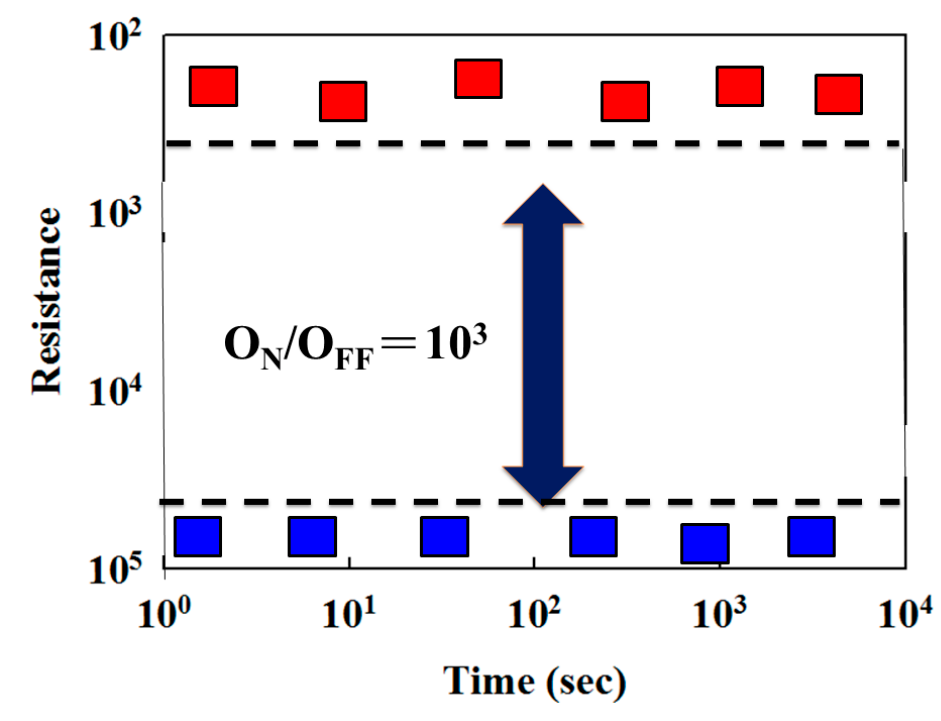
Figure 9. The resistance value versus switching cycle curves of the vanadium thin film RRAM de- vices.